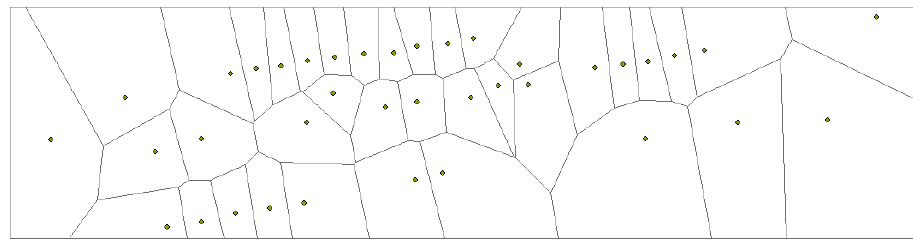
Figure 5. Segmentation of overlapping trees by Voronoi diagram (The black points represents the planar projection of the trunk centroid points).